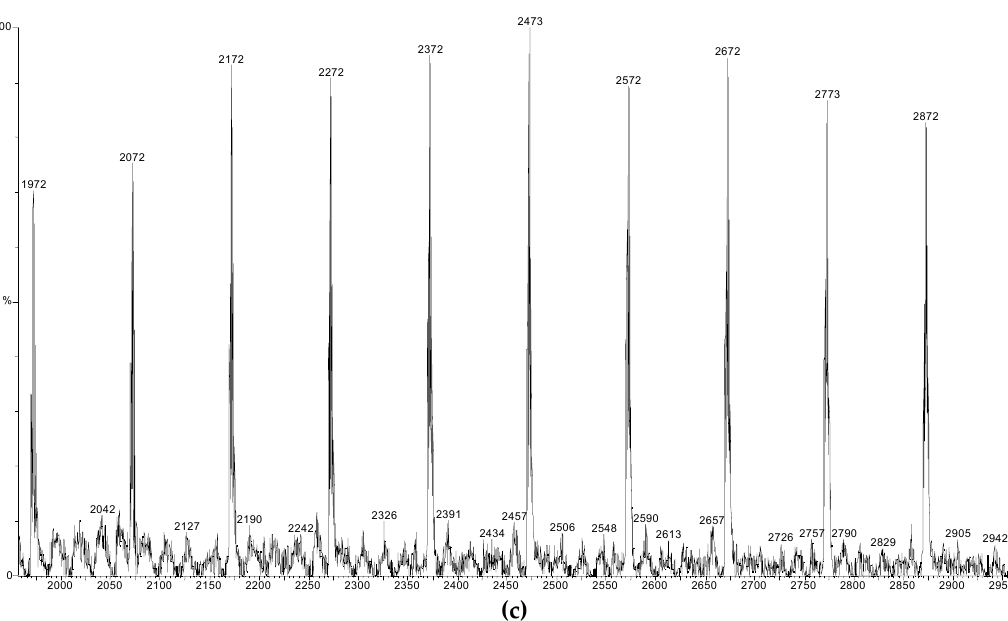
Figure 3. MALDI ToF mass spectra of ( a ) polymers ( 13 ), ( b ) polymer ( 17 ) and ( c ) polymer ( 18 ).